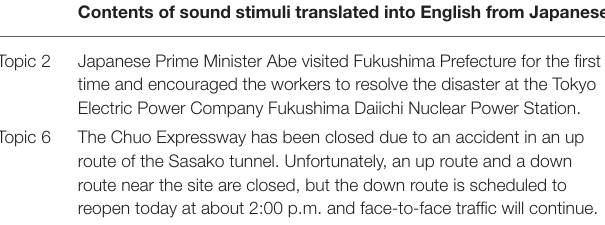
TABLE 1 | Example of part of Japanese radio